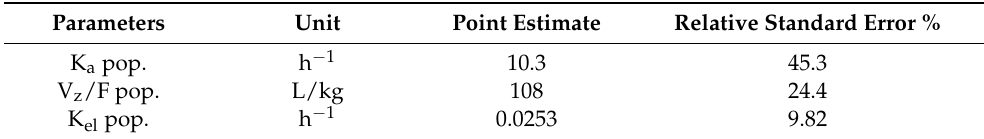
Table 2. Individual for serum doxycycline concentration after intragastric administration of doxycy- cline at 10 mg/kg q12 h from 0 to 48 h in 8 healthy jennies. Parameters Minimum Quartile Q1 Median Quartile Q3 Maximum K a 0.102 1.89 20.4 60 171 V z /F 20.9 62.5 115 204 311 K el 0.0253 0.0253 0.0253 0.0253